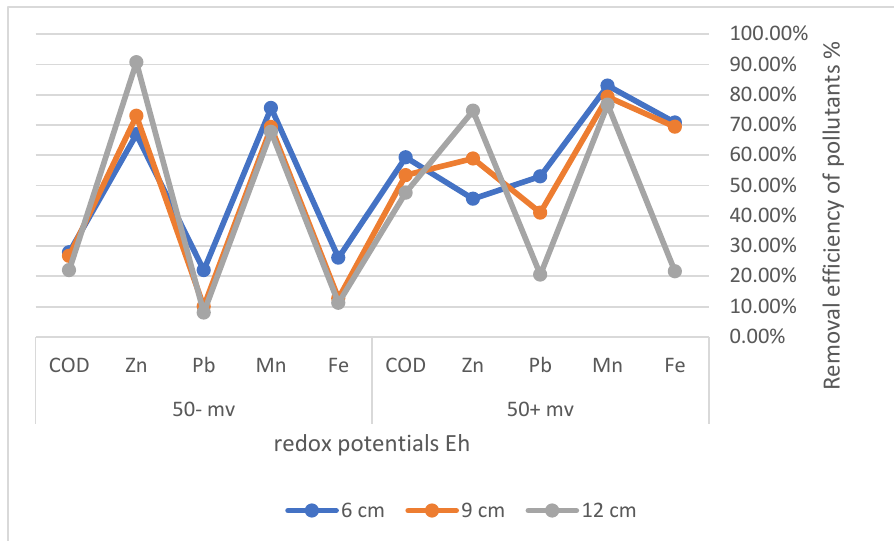
Fig. 3: Removal effectiveness of the pollutants by the PEC treatment according to the first set of analysis